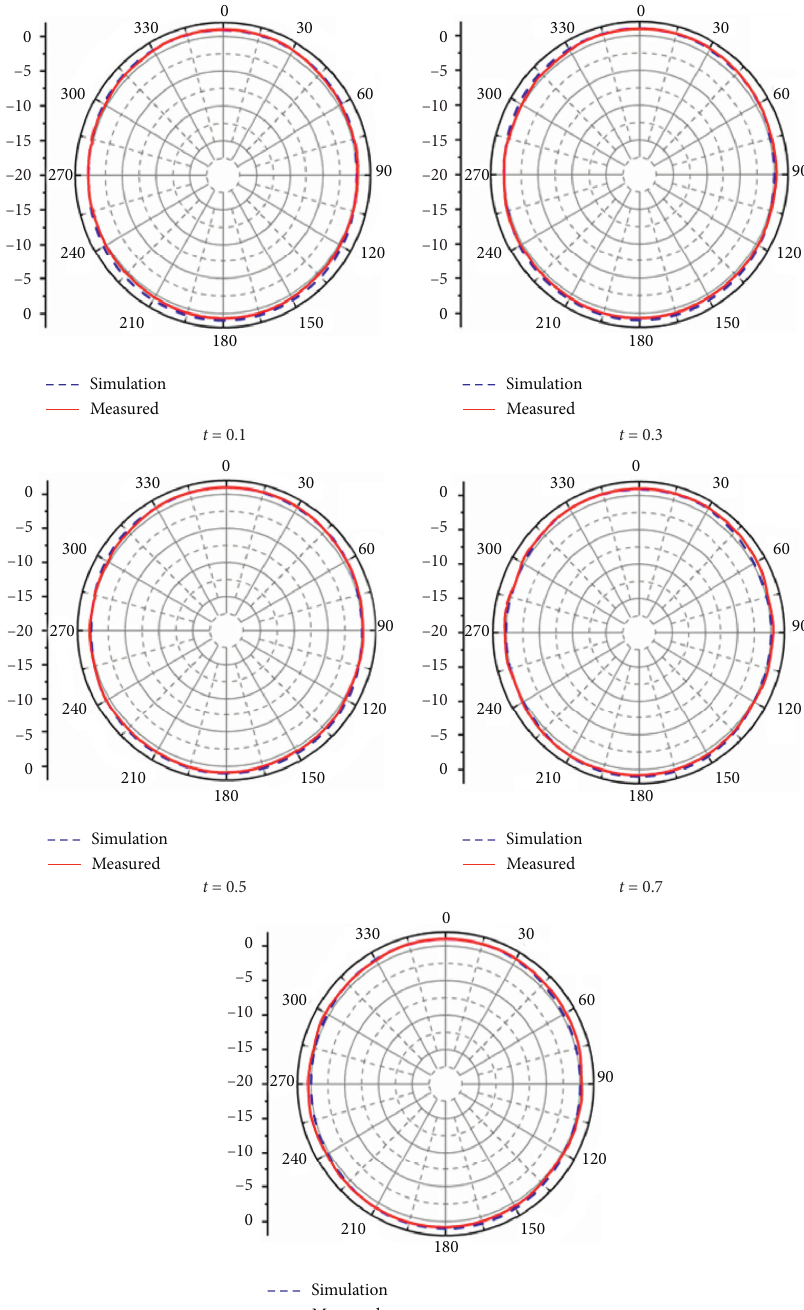
Figure 11: H-plane pattern with different t